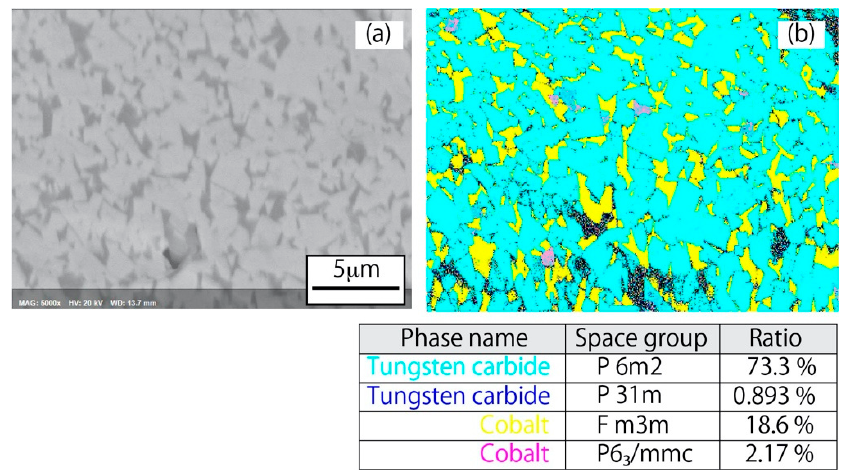
Figure 13. ( a ) SEM picture; and ( b ) EBSD phase map of powder cross-section for the plasma-treated WC–12%Co powder.